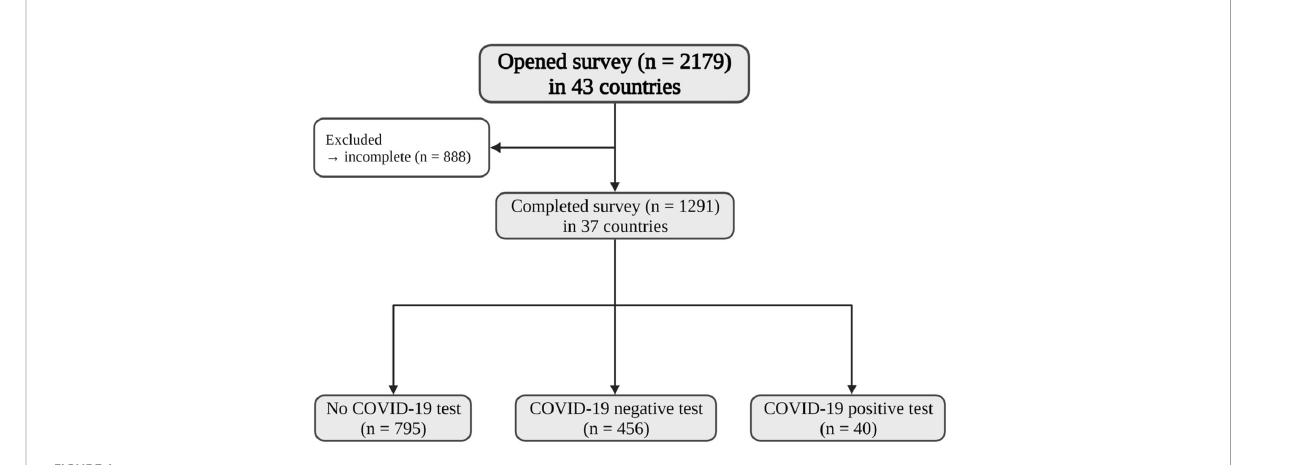
FIGURE 1 Flow Chart − Survey respondent inclusion criteria and COVID-19